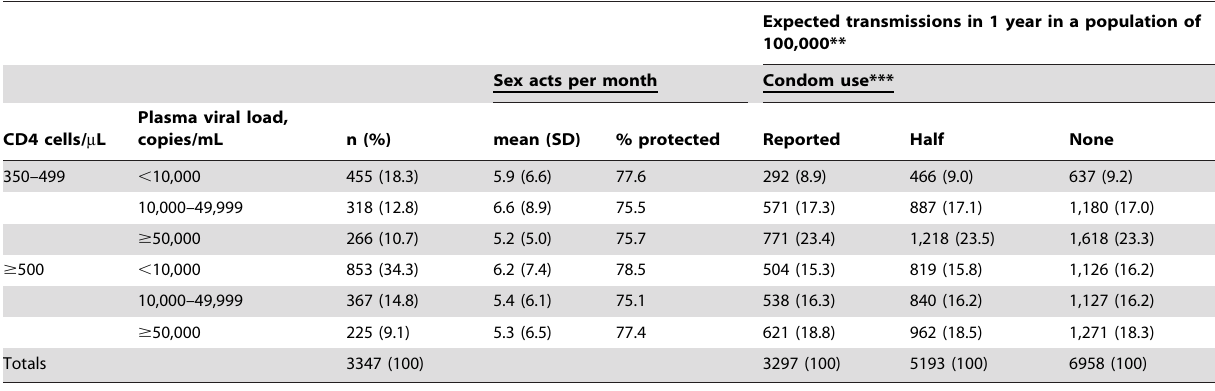
Table 1. Sexual behavior and expected HIV-1 transmissions in one year, stratified by CD4 count and plasma viral load.